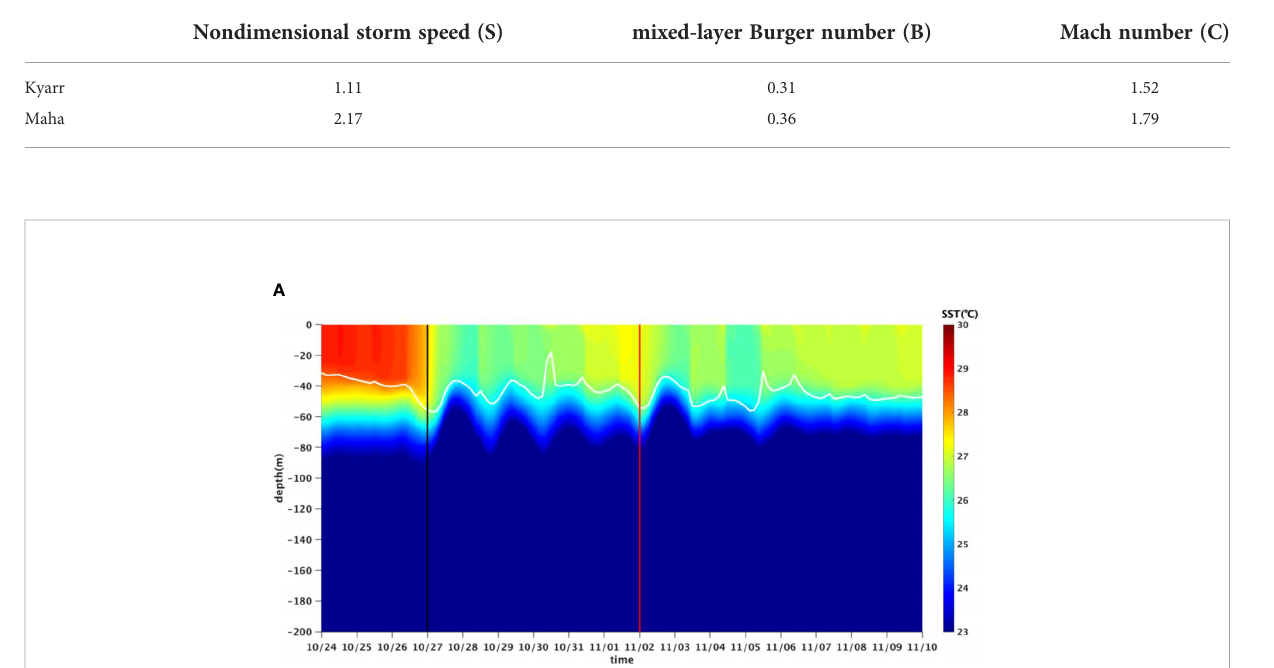
TABLE 4 Nondimensional variables.